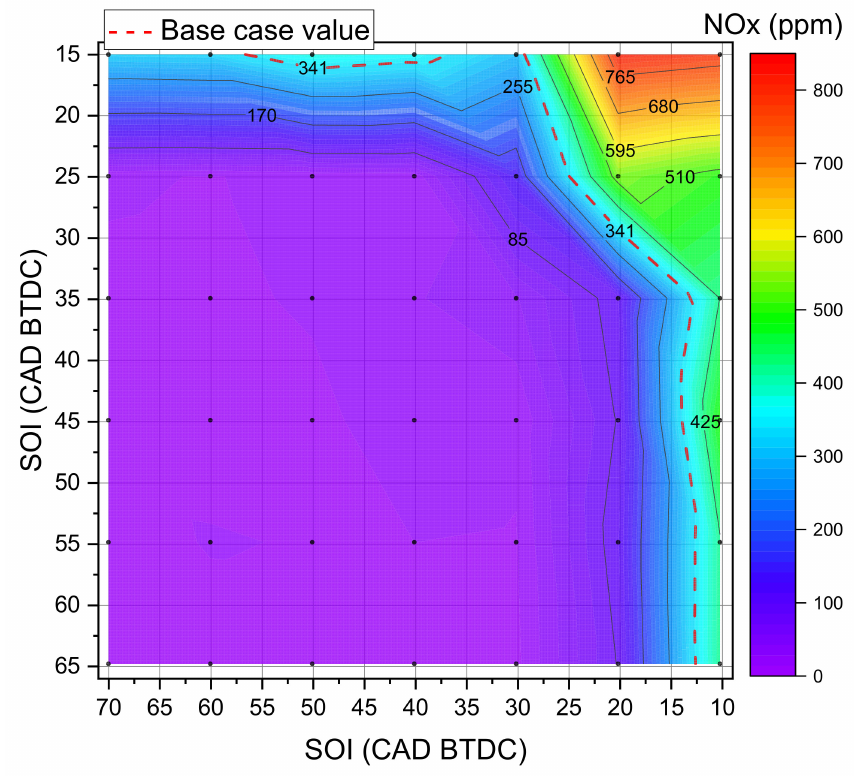
Figure 12. NO x concentration contour